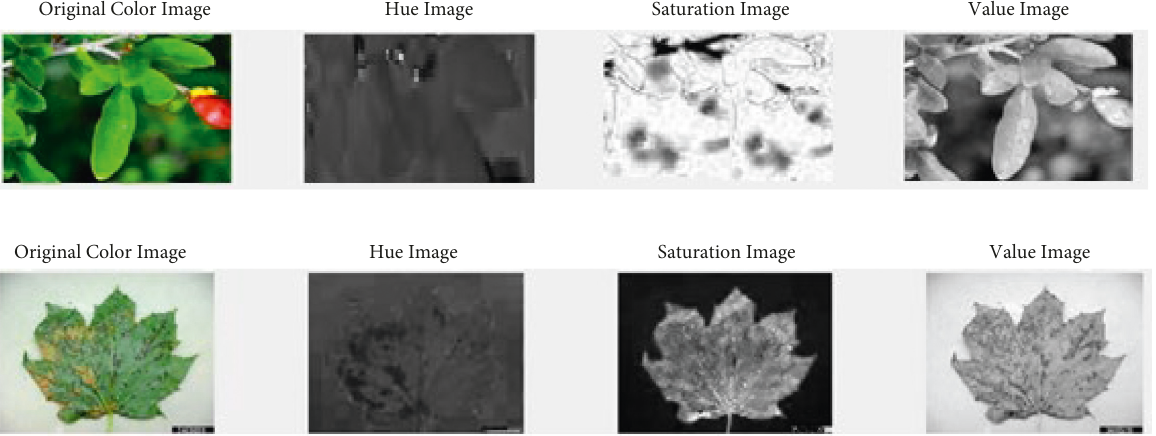
Figure 5: HSV image representation of healthy and dead leaf images.